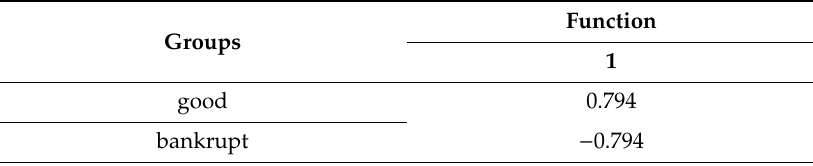
Table 4. Functions at group centroids from discriminant analysis.